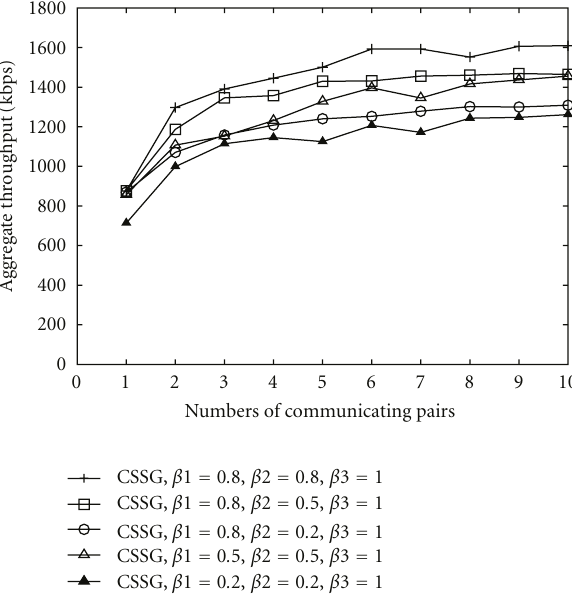
Figure 14: Aggregate throughput of POMDP with 1 channel having PU’s interference.